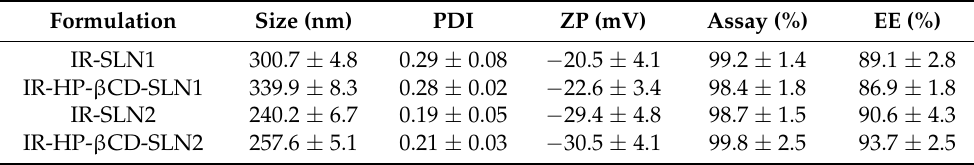
Table 4. Physicochemical characteristics of IR-SLNs and IR-HP- β CD-SLNs (mean ± SD, n = 3).